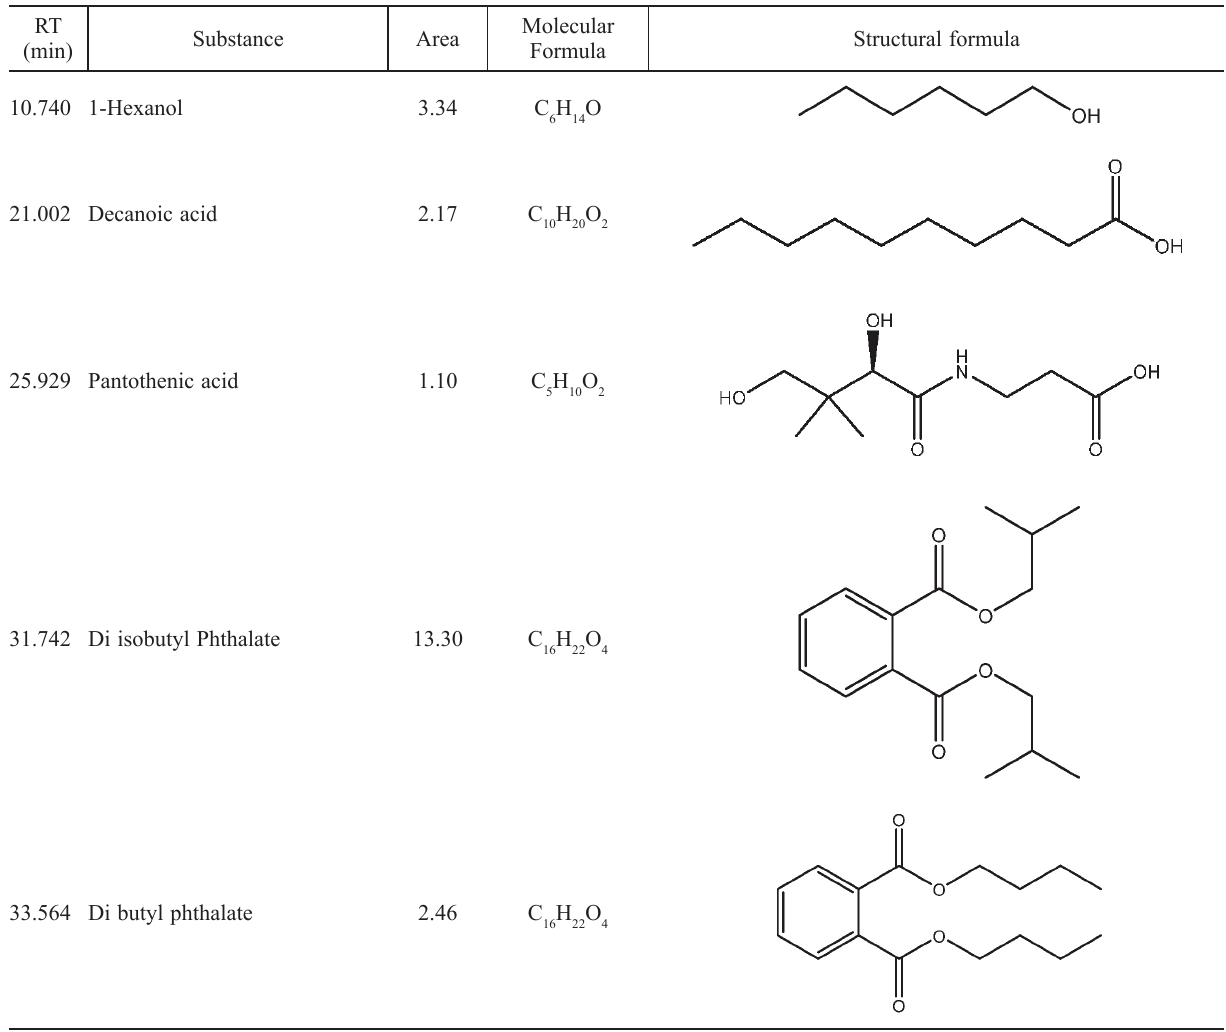
Table 4 – Gc-MS chromatogram of treated saline petrochemical wastewater by PPc process on produced intermediates (Initial coD: 710 mg l –1 , voltage: 1.5 V, pH: 4, electrode distance: 2 cm, reaction time: 24 h) RT (min)